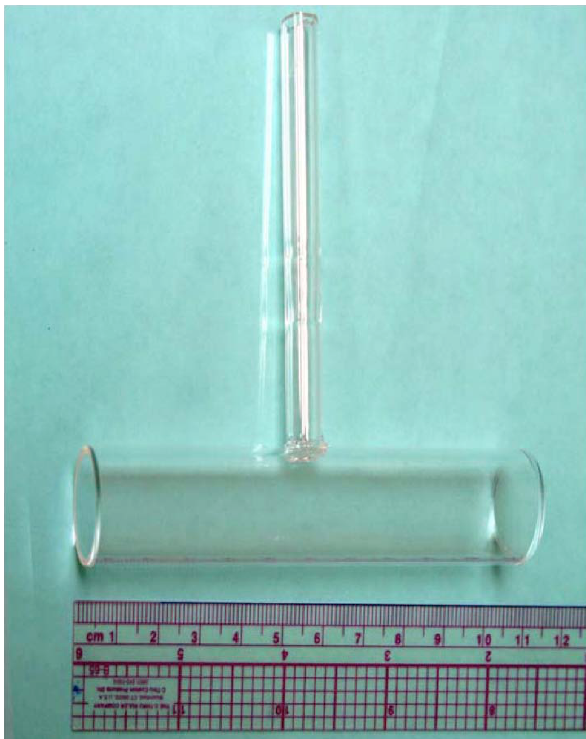
Fig. 1. Unsealed quartz reference cell. The seal tube has graded transitions from quartz to pyrex, where the cell is sealed. The op- tical path length along the cell axis is 10cm and the window outer diameter is 2.2cm. The cell front window was tilted by 1 ◦ angle with respect to the incoming beam.